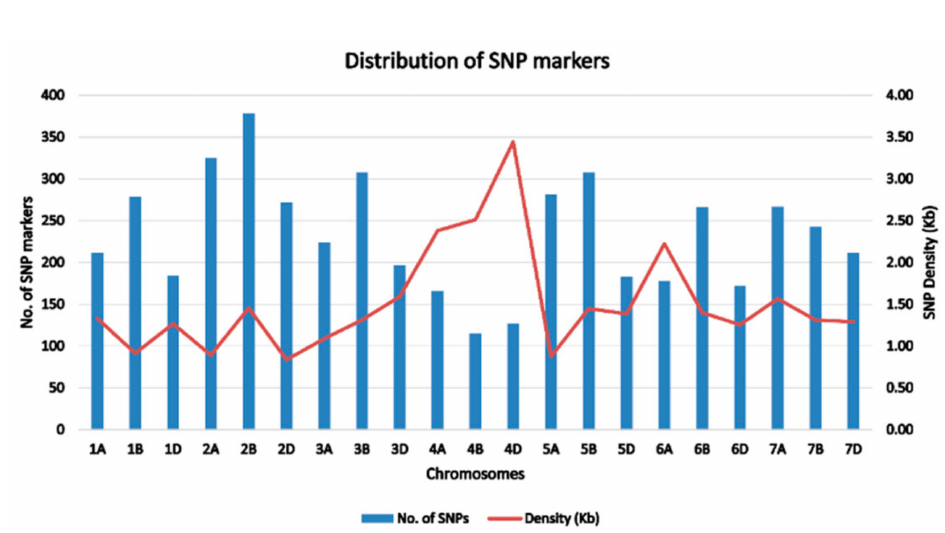
Figure 2. Distribution and the corresponding single nucleotide polymorphism (SNP) densities of 4897 SNPs across 21 chromosomes of bread wheat landraces from